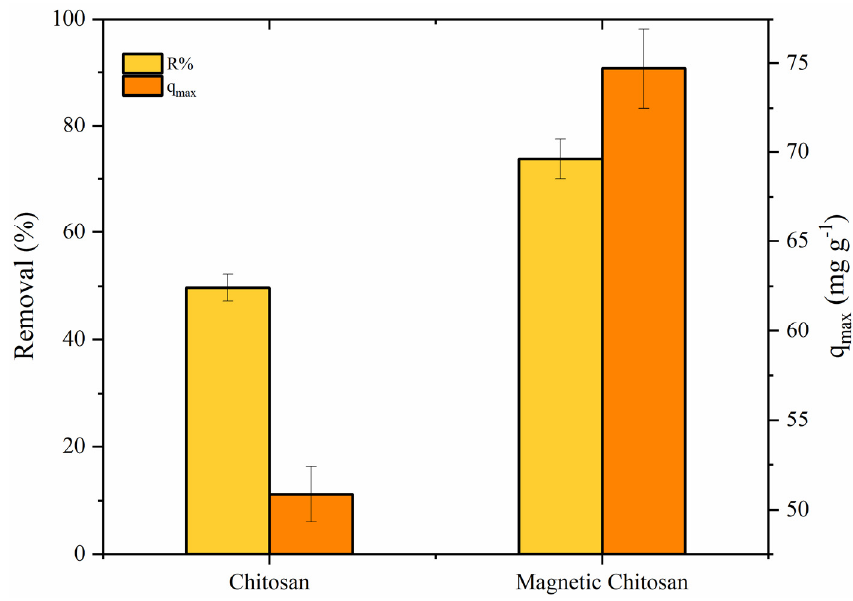
Figure 7. Effect of magnetite incorporation onto chitosan surface. Adsorbent dosage (0.5 g L − 1 ), initial concentration of TC (50 mg L − 1 ), pH = 7.0, and 293.15 K.